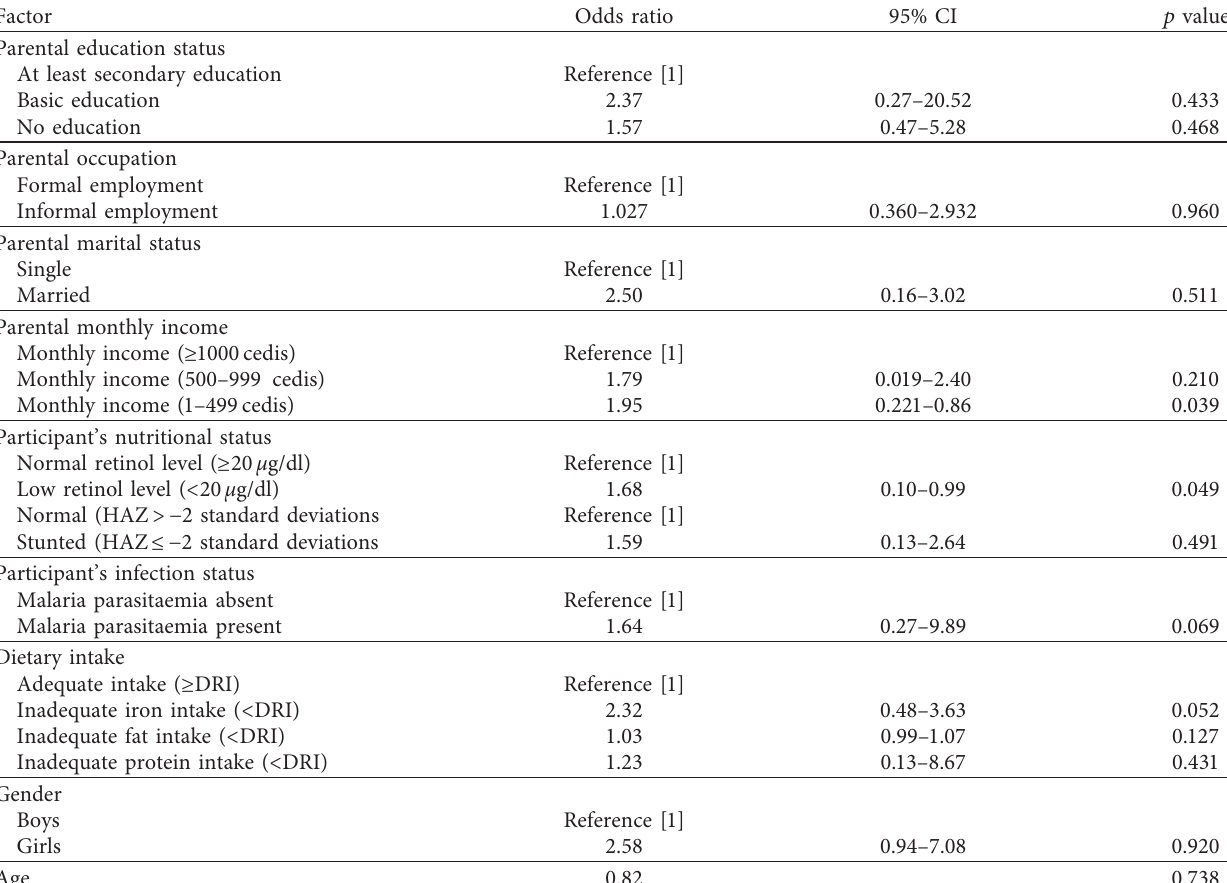
Table 2: Factors associated with anaemia in the study participants at